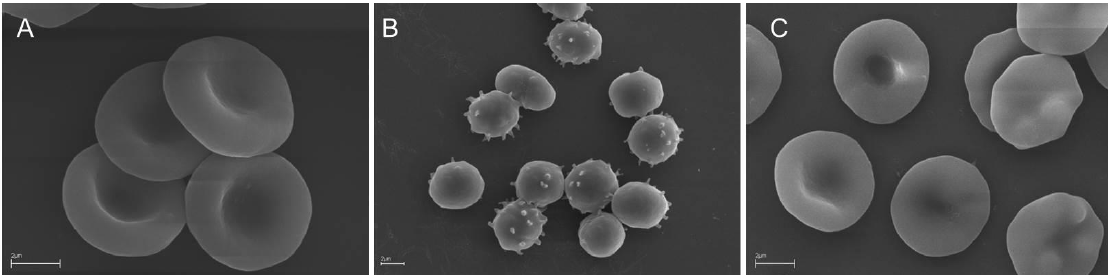
Figure 1. SEM micrographs showing human RBCs incubated ( A ) with phosphate-buffered saline (PBS buffer) for 5 h (control cells) and ( B ) with 60 mM AAPH for 4 h. ( C ) RBCs preincubated with the propolis extract (0.05 mg/mL) in 96% ethanol (EEP96) for 20 min and incubated with 60 mM AAPH for 4 h. Dominant RBC shape: ( A ) discocytes; ( B ) spheroechinocytes (spiculated spherocytes) and spherocytes (swollen, hemolytic RBCs); ( C ) discoechinocytes. The images show representative data after 1 h of independent experiments. Scale bars indicate 2 µm.